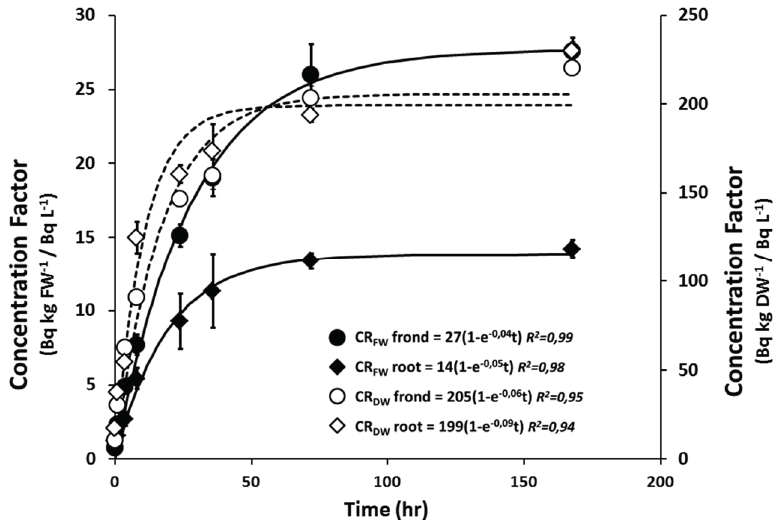
Figure 1. Time course of Sr 90 uptake in L. minor for time period of 168 hours exposed to 10 kBq·L − 1 of 90 Sr. Black dots refers to concentration ratios on fresh weight for frond and root, white dots refers to concentration ratios on dry weight for frond and root. Legend shows the equation of each fit with the R 2 value. Each data point represents the mean ± SE of six biological